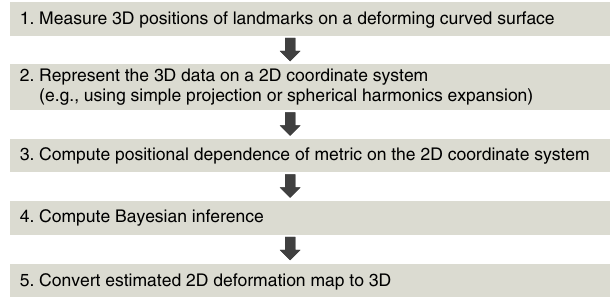
Fig. 3 Flowchart of estimating tissue deformation maps from landmark Fig. 2 Mathematical description of epithelial-sheet deformation. a Geometrical view of tissue deformation. When the scale of organs is much larger than that of a cell, tissue-level deformation can be described as a map of continuum. The deformation map of a surface has 3D and 2D representations ( x = ϕ ( X ) and u ¼ ~ ϕ ð U Þ , respectively). H ( X ) and h ( x ) are functions that indicate how to transform a 3D coordinate into 2D at different time points (T 1 and T 2 ). With these functions, the relationship ϕ ¼ h (cid:2) 1 (cid:3) ~ ϕ (cid:3) H holds. In our method, using positional data from sparsely labeled cells, the 2D map modeled by lattice deformation is estimated; the deformation of the gray region from ~ Ω to ~ ϕ ð ~ Ω Þ shows an example. The regions ~ Ω and ~ ϕ ð ~ Ω Þ can be linked to their 3D representations (i.e., Ω and ϕ ( Ω )) through the functions H − 1 ( U ) and h − 1 ( u ), respectively. After the map is determined, local tissue deformation can be calculated from the deformation gradient tensor ~ F . In the fi gure, the local deformation around a point ~ p in a 2D coordinate system (from Δ ~ Ω p to ~ F ð Δ ~ Ω p Þ ) is shown. As a result of compressing a curved surface into a fl at plane, the metric differs depending on the position in the 2D coordinate systems ( ~ G αβ ð U Þ and ~ g ð u Þ ). The bottom fi gure shows examples of the positional dependence of metric calculated from the spherical harmonics used for modeling the 3D αβ morphologies at time points T 1 and T 2 shown in the fi gure. Different ellipses with different colors show the metric anisotropy at their positions. b Using the metric ~ g , the neighborhood of each point in the 3D representation ( Δ x T Δ x = const., shown as red circles ) can be approximated by Δ u T ~ g Δ u ¼ const. in 2D. c In the process of estimating deformation maps from landmark positions, we assumed that the observed positions include an additive noise obeying isotropic Gaussian distribution ( ξ i ) on the tangent plane at each point in the 3D representation. In the 2D representation, the noise distribution becomes anisotropic ( ~ ξ i ) due to metric anisotropy. The variance-covariance matrix was modeled as ~ Σ ð i Þ ffi σ 2 ~ g (cid:2) 1 ð u i Þ using the metric at the observed position in the 2D coordinate system of each landmark. σ represents noise magnitude. Including this noise anisotropy into the likelihood function improves the estimation performance (see Fig. 4)